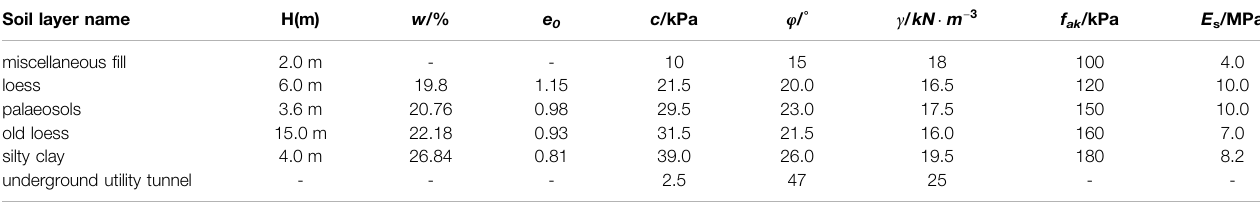
TABLE 1 | Speci fi c parameters of numerical simulation.